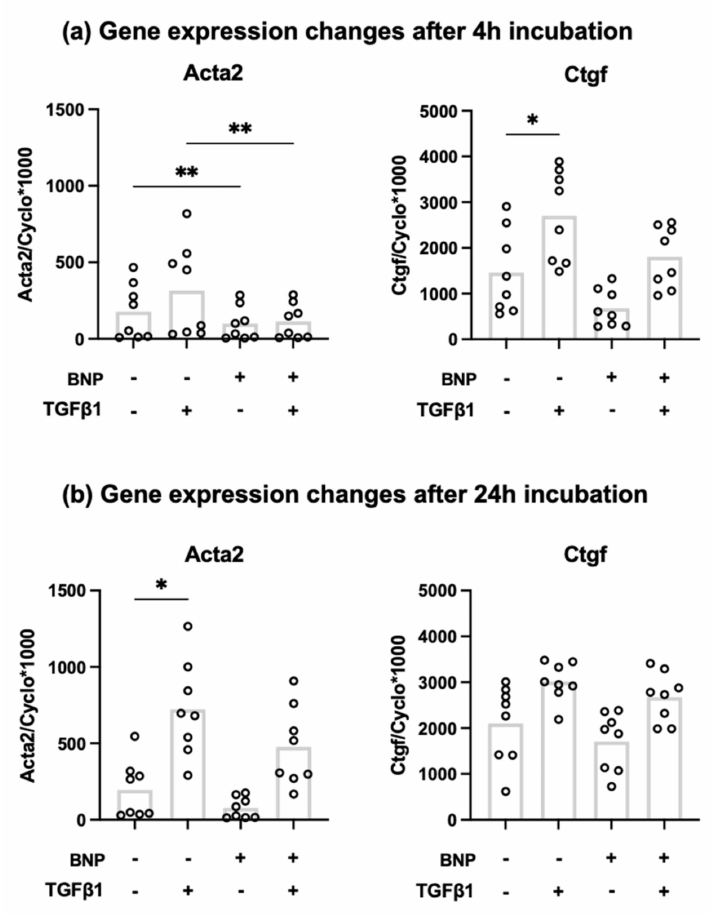
Figure 2. Relative mRNA expression levels of Ctgf and Acta2 in cardiac fibroblasts exposed to recombinant BNP and/or TGF β 1 after 4 h ( a ) and 24 h ( b ) ( n = 8) * p < 0.05; ** p < 0.01. Bar indicates